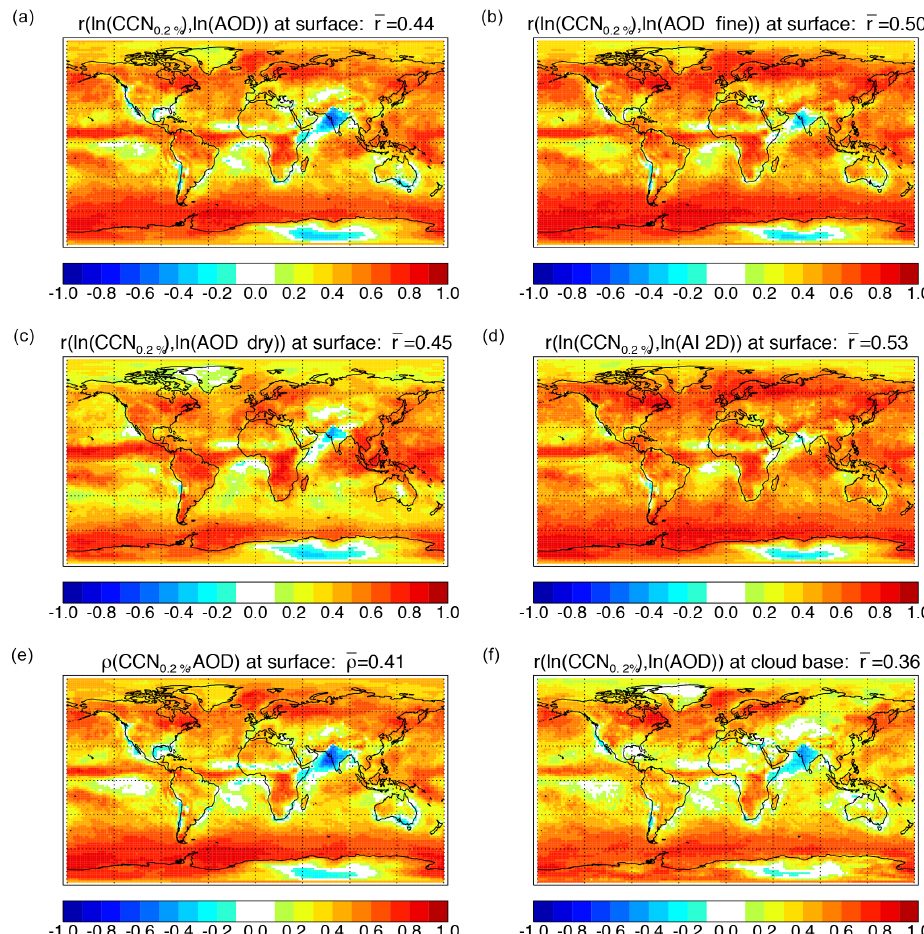
Figure 7. Map of Pearson’s correlation coefficient of ECHAM-HAM simulated CCN 0 . 2% with aerosol radiative properties for (a) surface CCN 0 . 2% with vertically integrated aerosol optical depth, (b) surface CCN 0 . 2% with vertically integrated fine mode aerosol optical depth, (c) surface CCN 0 . 2% with vertically integrated dry aerosol optical depth, (d) surface CCN 0 . 2% with vertically integrated AI, (e) Spearman’s rank correlation coefficient for surface CCN 0 . 2% with vertically integrated AOD and (f) Pearson’s correlation coefficient of CCN 0 . 2% sampled at cloud base with vertically integrated AOD. Global-mean correlation coefficients are given in the title of each plot.